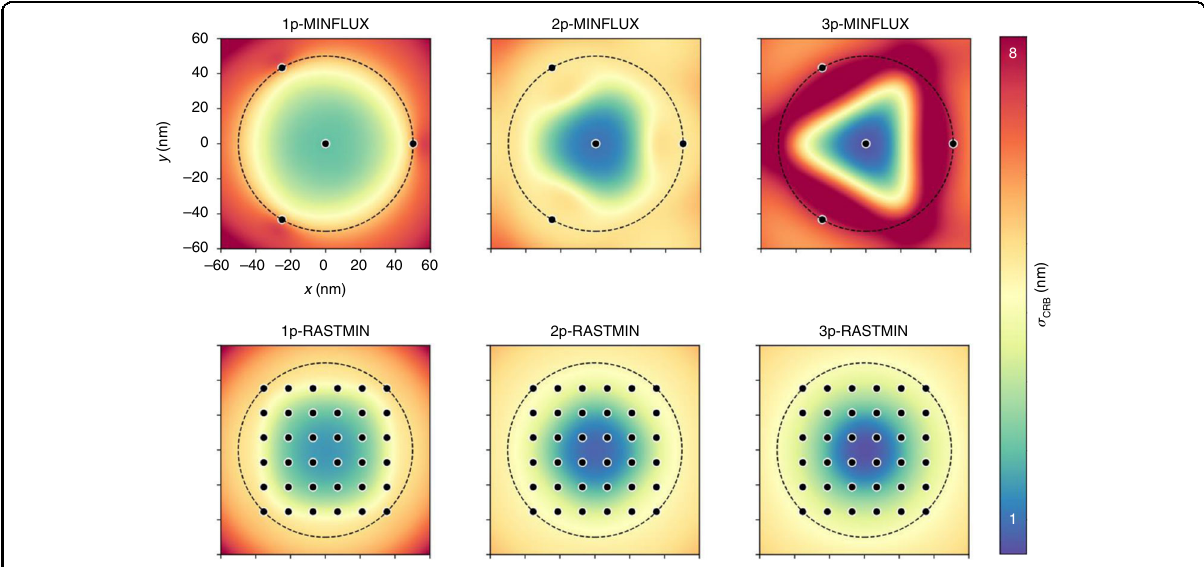
Fig. 1 Precision maps (localization error lower bound σ CRB as a function of the emitter position) for equivalent con fi gurations of MINFLUX and RASTMIN, for 1-photon, 2-photon, and 3-photon excitation. Parameters: L = 100 nm, N = 500, SBR = 4, λ = 647, 800, and 1300 nm for 1-, 2- and 3-photon processes,